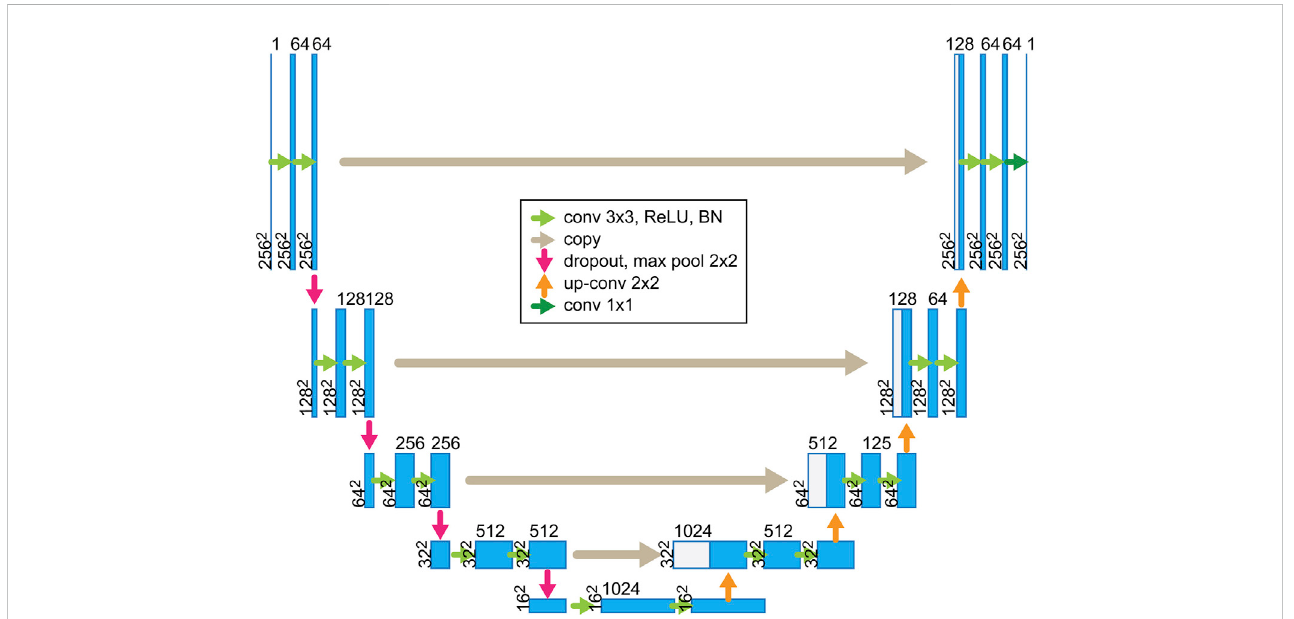
FIGURE 1 Architectureoftheconvolutionalauto-encodertrainedfordenoising(modi fi edfromRonnebergeretal.(2015)).Thenetworkconsistsofanencoderand adecoder.Theencoderontheleftsidecompressesinputsintolow-dimensionalspacestoextractfeatures,andthedecoderontherightsideusesthefeatures to predict data.